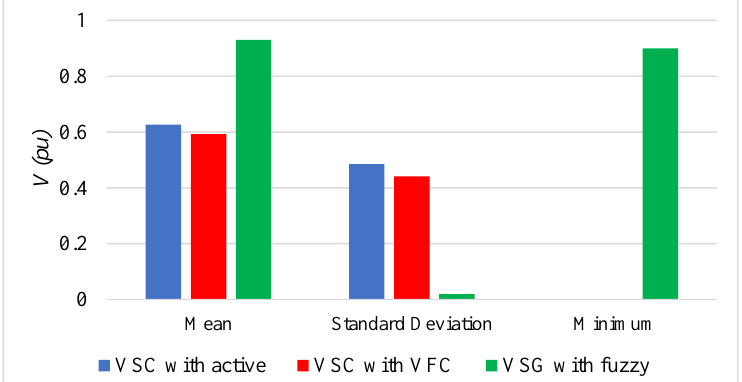
Figure 18. Voltage statistics of the system for various scenarios.